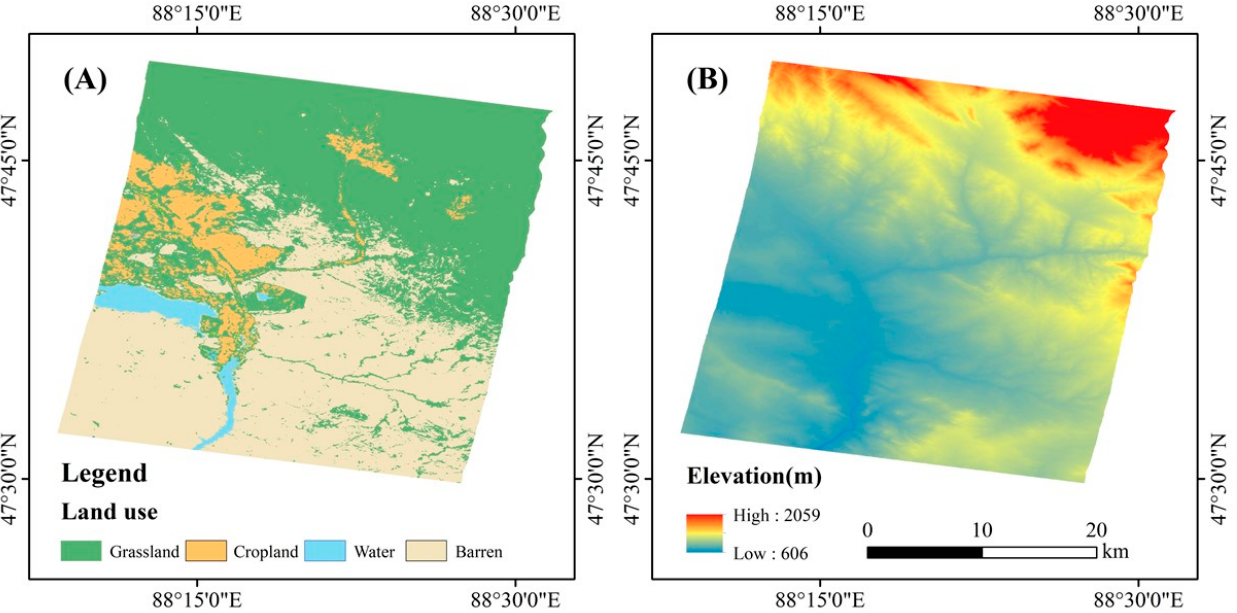
Figure 5. Land cover in the study area ( A ) and study area topography( B ).